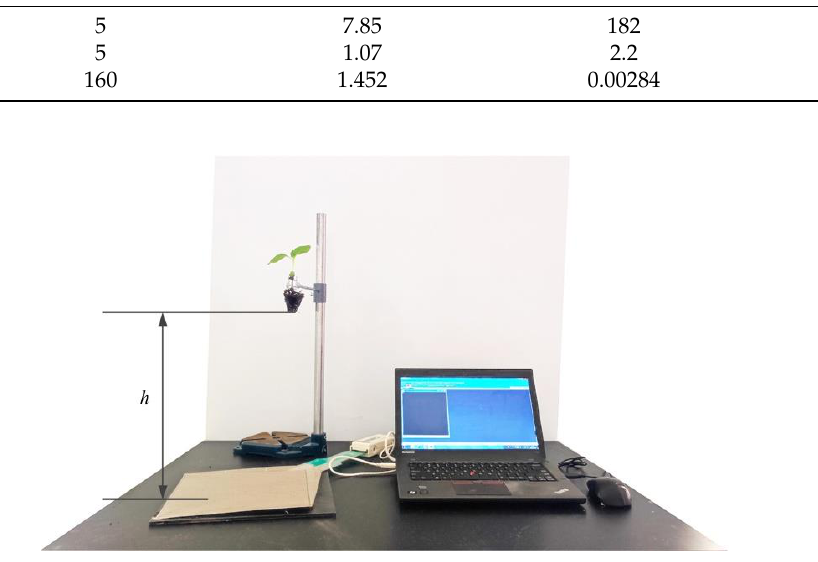
Table 1. Properties of three contact materials. Figure 3. Drop impact test on oil sunflower plug seedlings. ( a ) Drop impact test between oil sun- flower plug seedlings and the soil; ( b ) drop impact test between oil sunflower plug seedlings and steel plate. 1. Seedling gripper; 2. Frame; 3. 5250 flexible thin-film-network tactile pressure sensor; 4. Plug seedlings; 5. Plastic film; 6. Test soil bin; 7. Fastening bolts; 8. Computer and I-Scan System